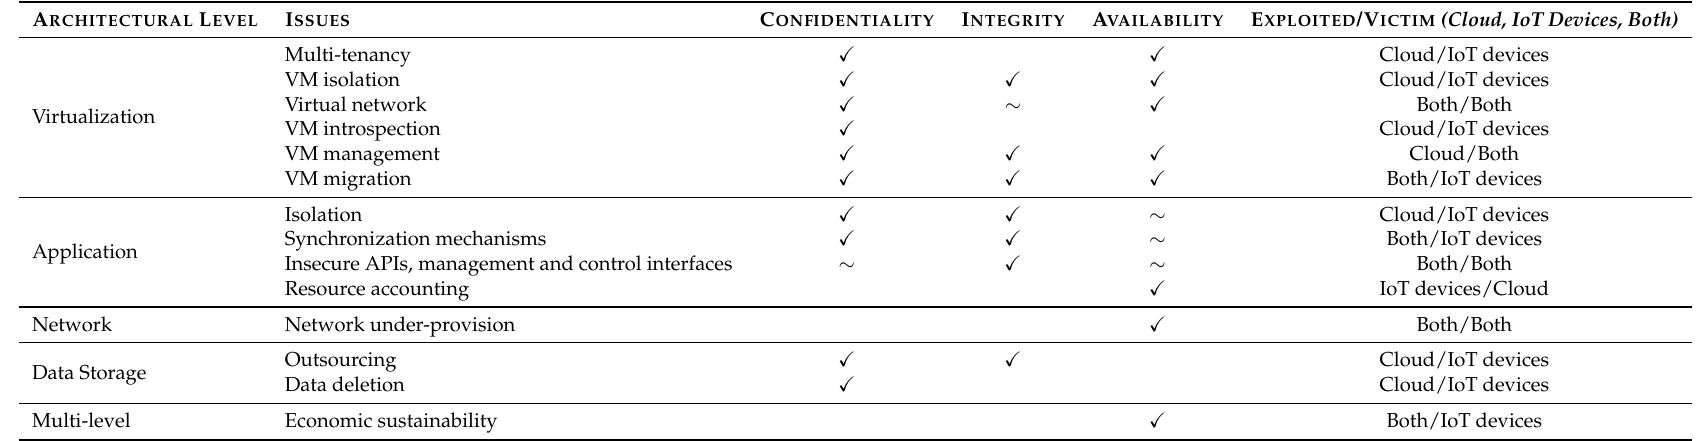
Table 1. Summary of Cloud-specific issues. “ (cid:88) ”: existence of literature works indicating that the issue affects the property. “ ∼ ”: despite we found no evidence in the literature, we believe that the issue might affect the property. E XPLOITED /V ICTIM : how parties of the IoT architecture (Figure 1) are affected from the issue.